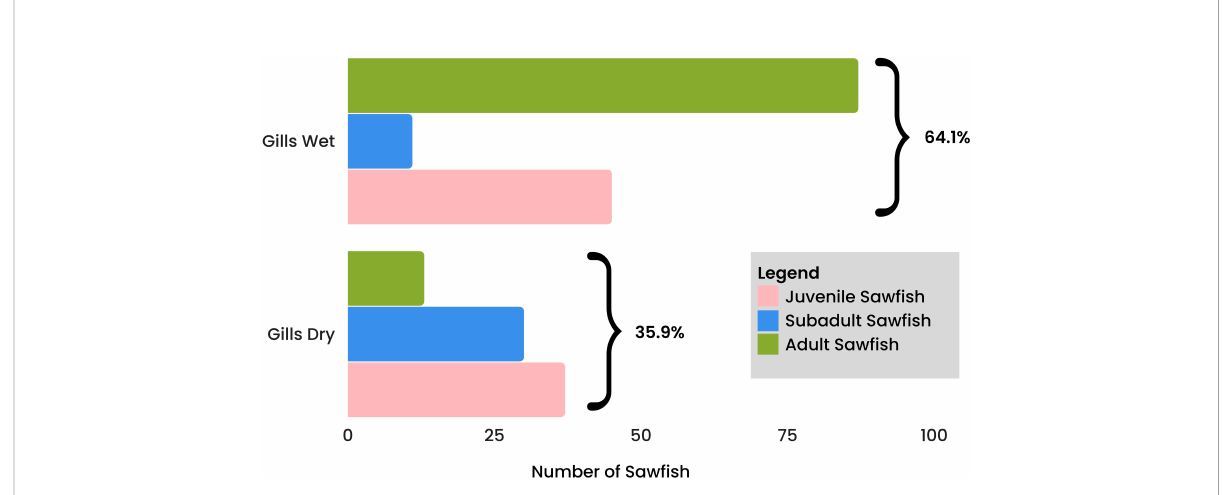
FIGURE 3 Number of saw fi sh with “ wet ” and “ dry ” gills, colors indicate lifestage with examples of